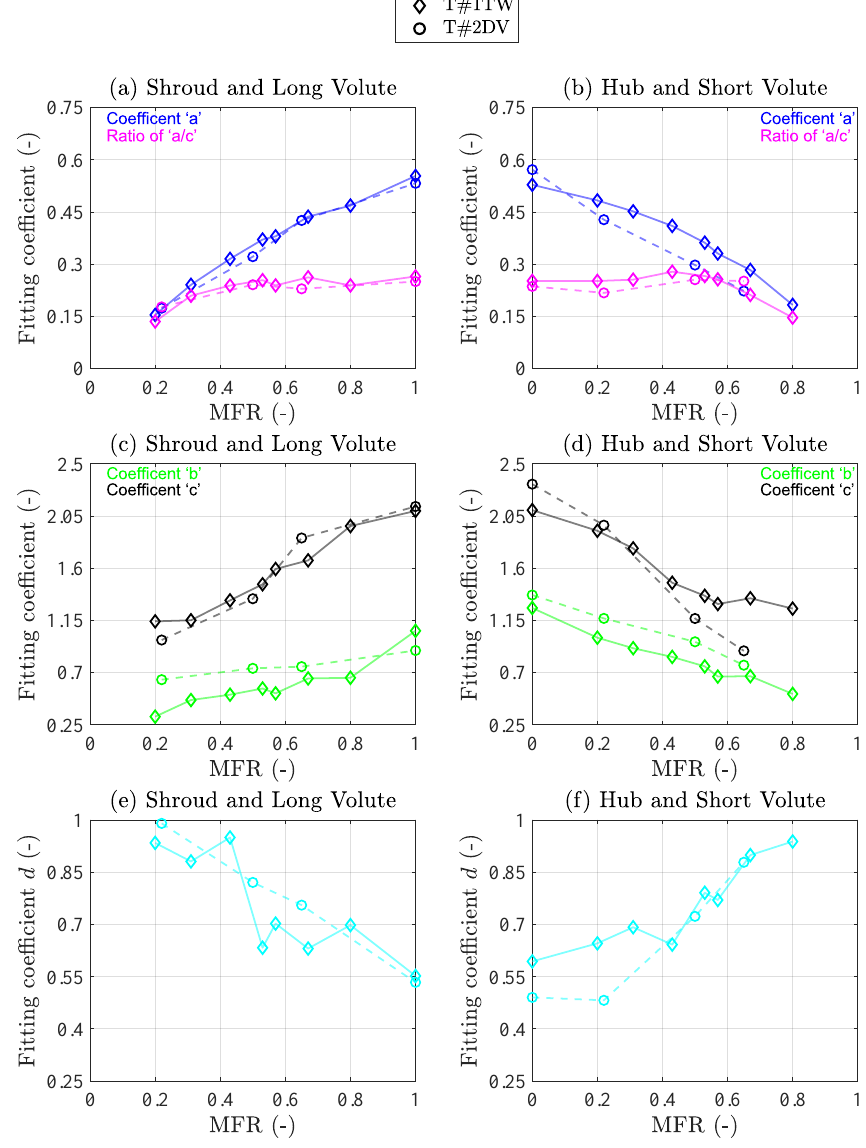
Figure 11. Reduced mass flow coefficients obtained using the individual MFR fitting for both T#1TE and T#2DV turbines. Each turbine entry map is fitted one by